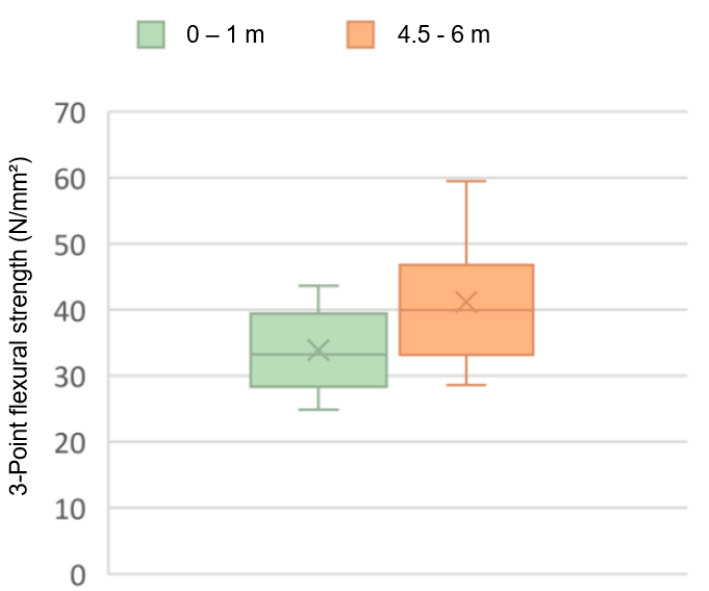
Figure 12. Modulus of rupture of Paulownia samples extracted at 0 − 1 m and 4.5 − 6 m from the tree stem.